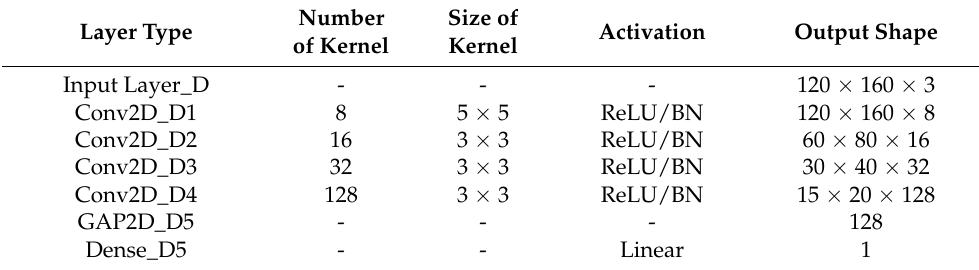
Table 3. The detailed structure of the discriminator